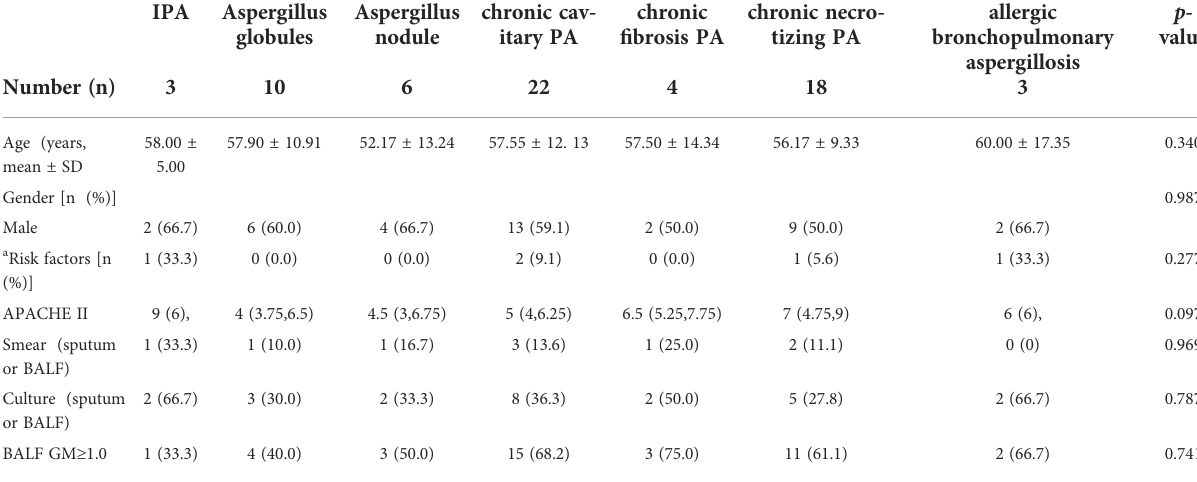
TABLE 3 Clinical characteristics of patients between seven